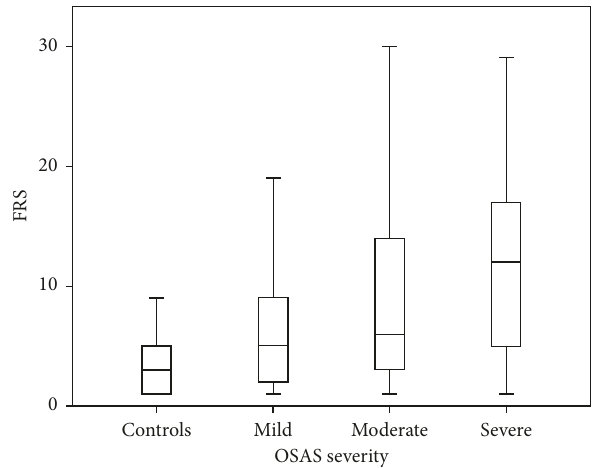
Figure 2: Comparison of Framingham Risk Score (FRS) between controls and obstructive sleep apnea syndrome (OSAS) patients.